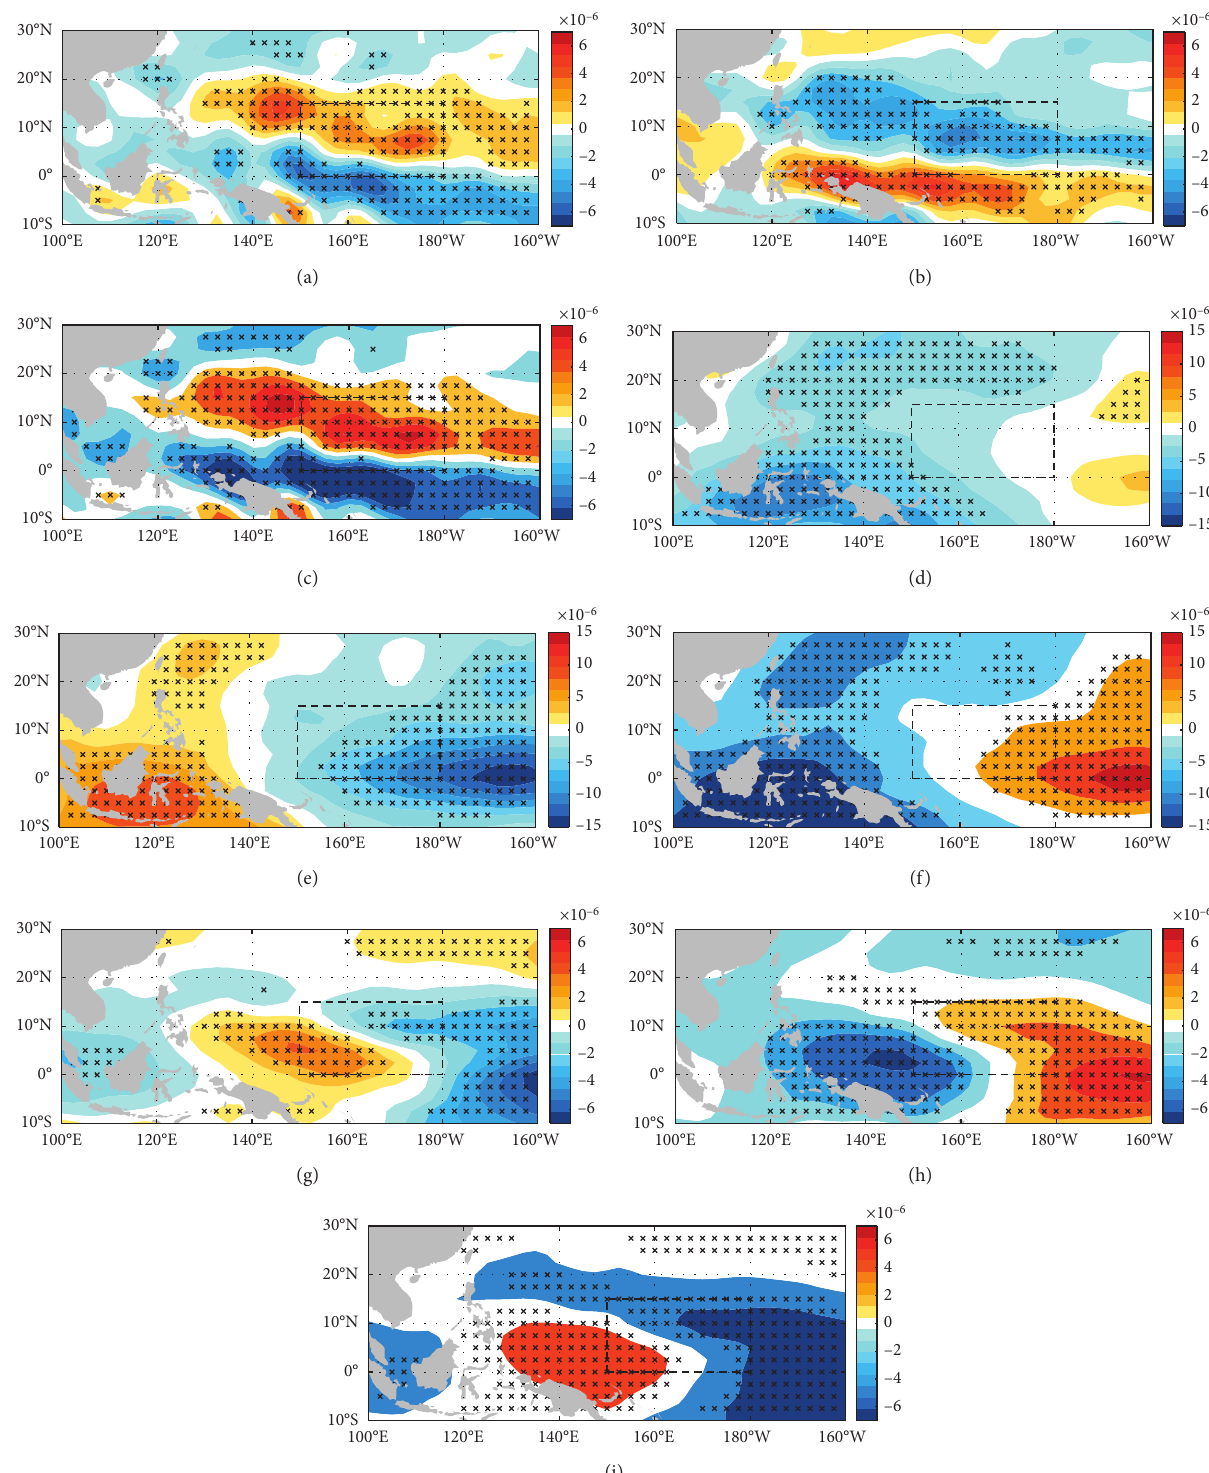
Figure 8: Composite anomalies of (a) absolute vorticity (units: s − 1 ), (d) relative humidity (units: %), and (g) vertical wind shear (uni- tsm · s − 1 ) in JASON season for the subsurface cold years; (b), (e), and (h) as in (a), (d), and (g), but for the subsurface warm years; (c), (f), and (i) for the difference of composite anomalies between subsurface cold and warm years (cold-warm). Dashed rectangle indicates the main TC genesis area of southeastern quadrant mentioned in Section 4.2. The cross signs indicate that the values are statistically significant at the 95% confidence